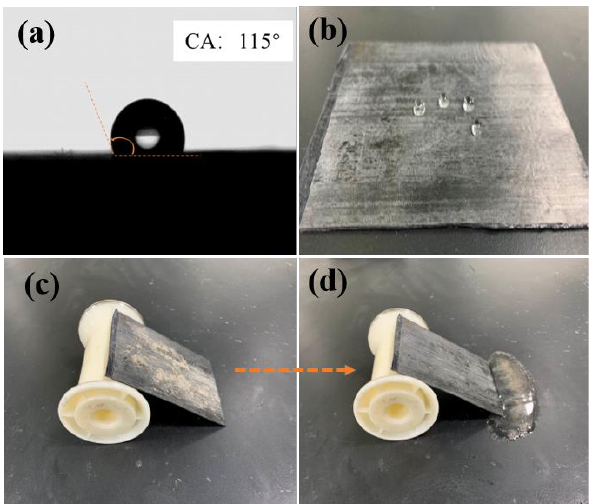
Figure 8. ( a , b ) Hydrophobicity and ( c , d ) self-cleaning property of CEC composite.